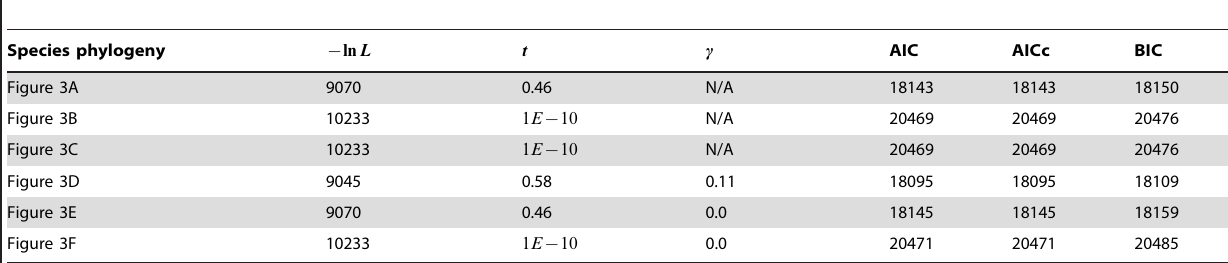
Figure 3 for the three Drosophila species Dmel , Dere , and Dyak .